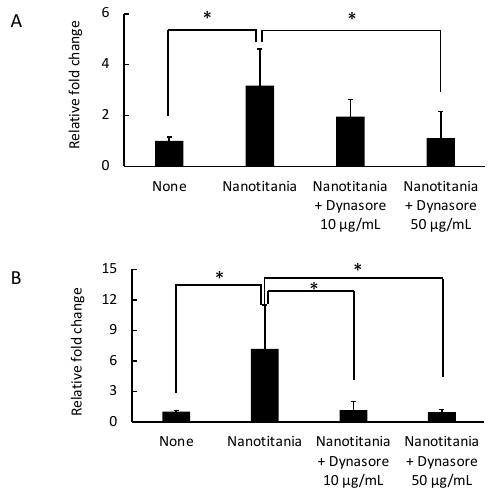
Figure 3. Effect of an endocytosis inhibitor on the expression of IL-6 ( A ) and IL-8 ( B ) mRNA expression was measured by qPCR. After the treatment with dynasore 10 or 50 mg/mL for 30 min, IL-6 and IL-8 mRNA expression was measured at 24 h incubation with 10 µg/mL nanotitania. Each data point indicates the average of six gene expression quantification results (n = 6). Bars indicate standard deviation, and asterisks indicate p < 0.05.